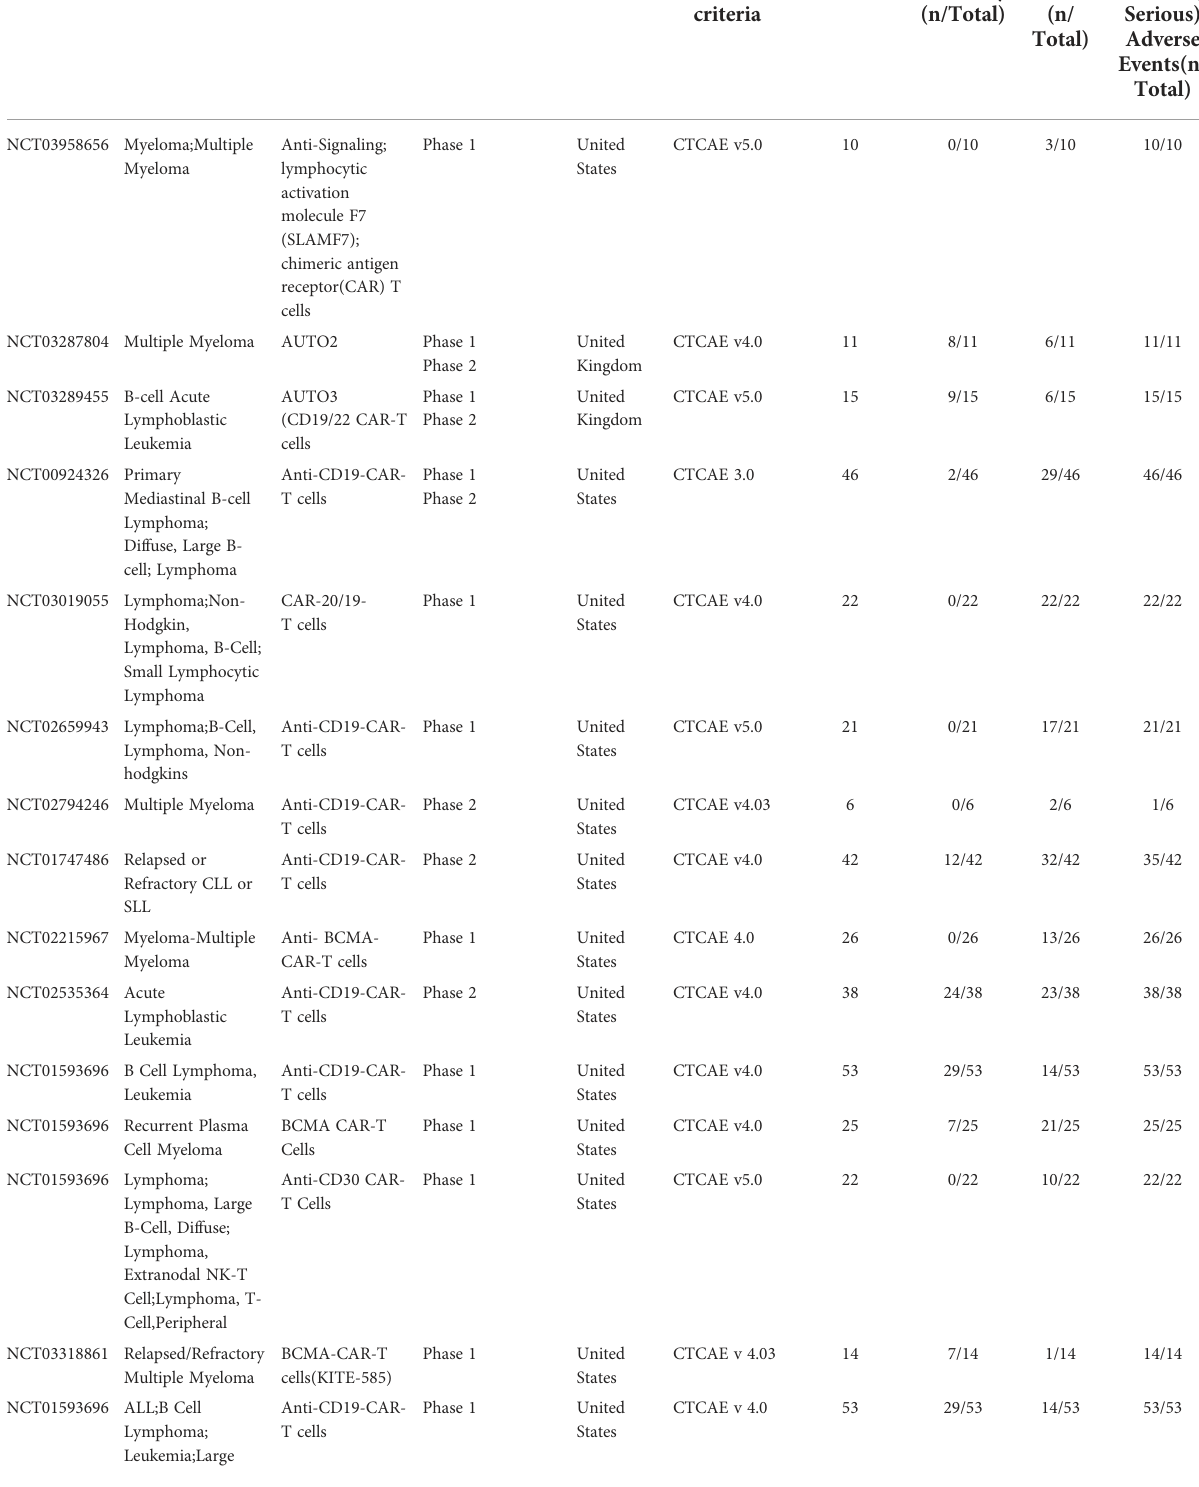
TABLE 1 The incidence of clinically serious adverse events of CAR-T in hematological